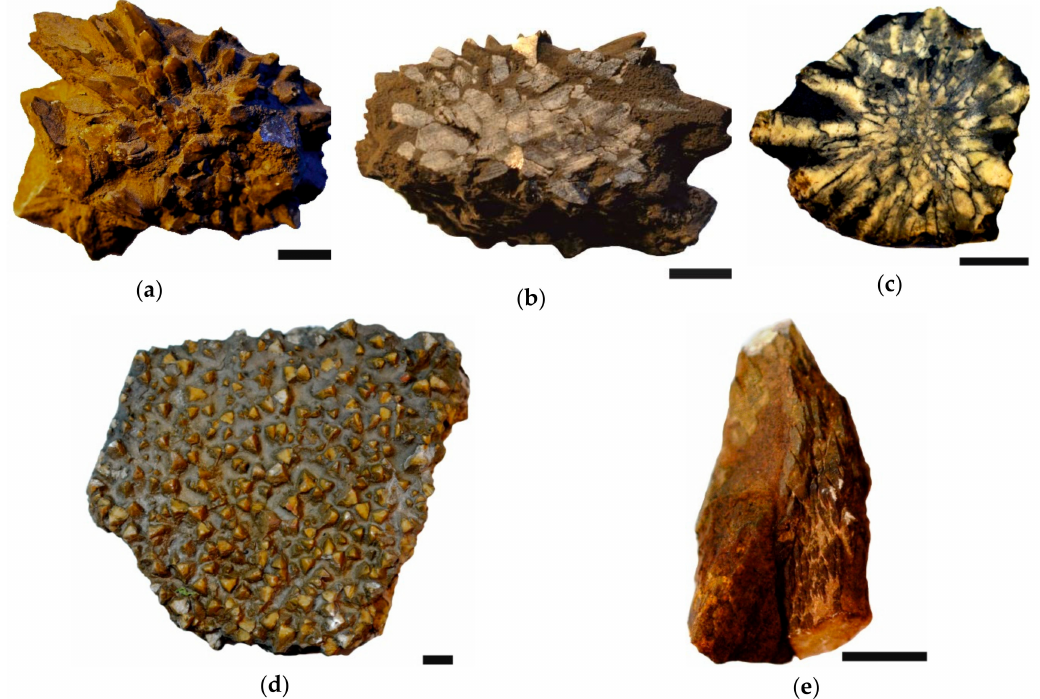
Figure 3. Morphology of studied anthraconites: ( a – c ) stellate-like anthraconites, ( a ) surface, ( b , c ) cross sections; ( d ) brush-like plate of calcite crystals; ( e ) anthraconite single crystal. Scale bar is 10